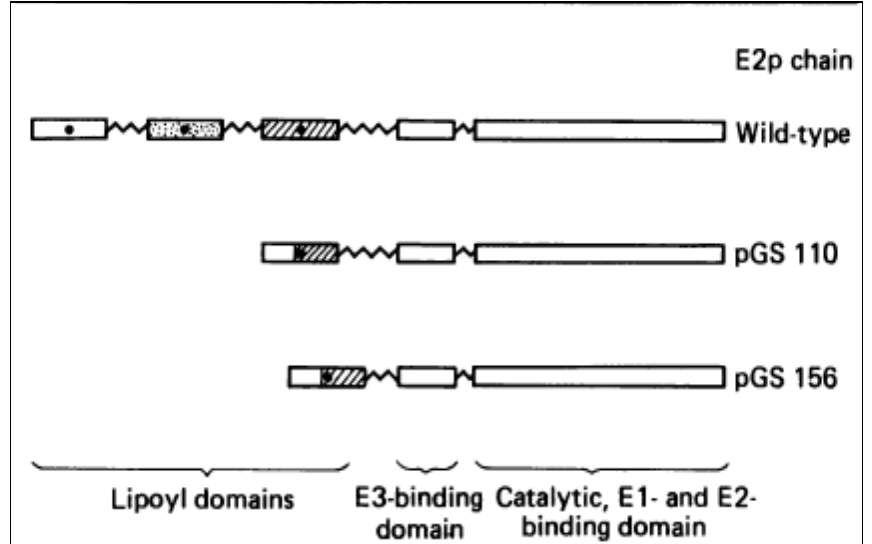
Figure 6. Schematic representation of the structure of the wild type, pGS110- and pGS156encoded E2p